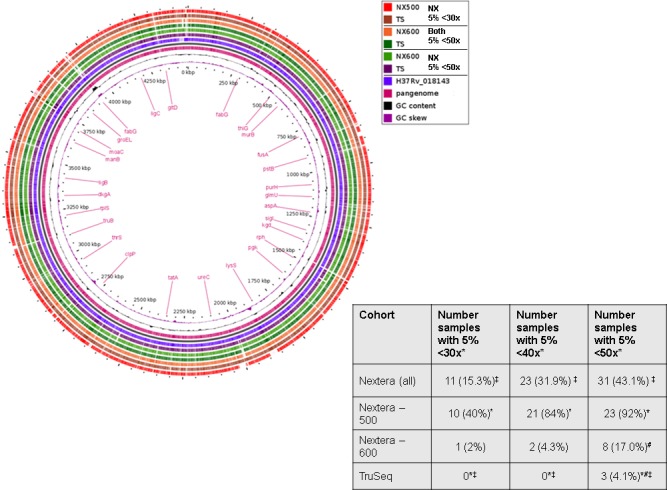
A) Pangenome analysis of the assembled whole genome sequence of two MTB isolates sequenced for this analysis. A cutoff average of 30x depth of coverage was used for inclusion of genomic regions in this image. B) Comparison of the number of isolates in which less than 5% of the genome fails to meet the specified depth of coverage. Symbols illustrate the observation of significant differences in proportion of samples between sequencing methods calculated using the paired McNemar test (p<0.05).